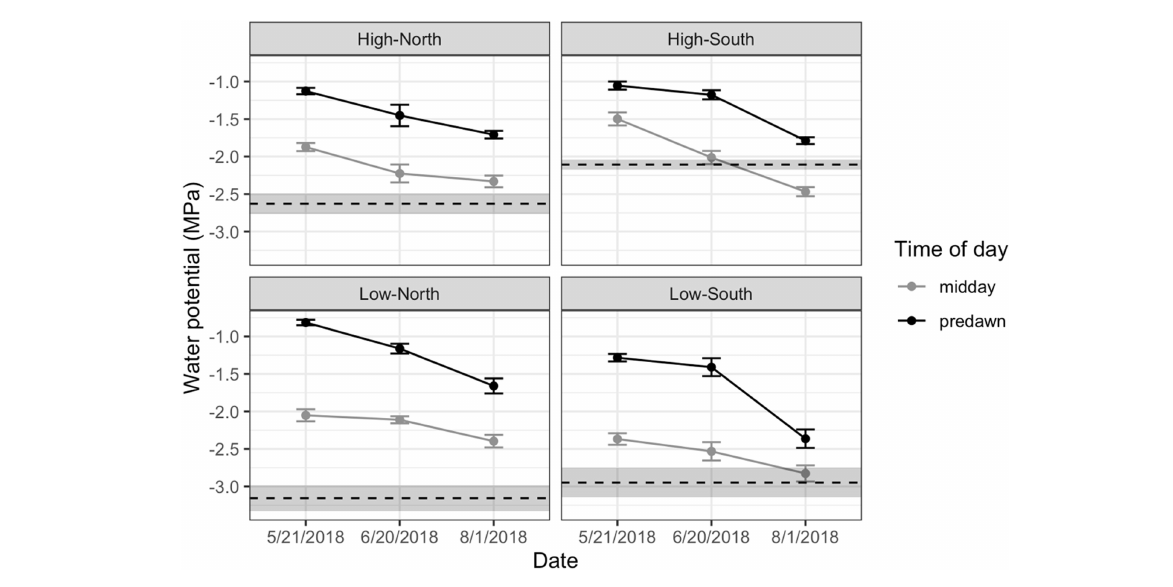
FIGURE4 Predawn (black) and midday (gray) leaf water potentials for all sites (High-North, High-South, Low-North, and Low-South). Dashed lines represent the mean turgor loss point measured for trees at each site. Error bars (water potential) and shaded area (turgor loss point) are ± 1 standard error